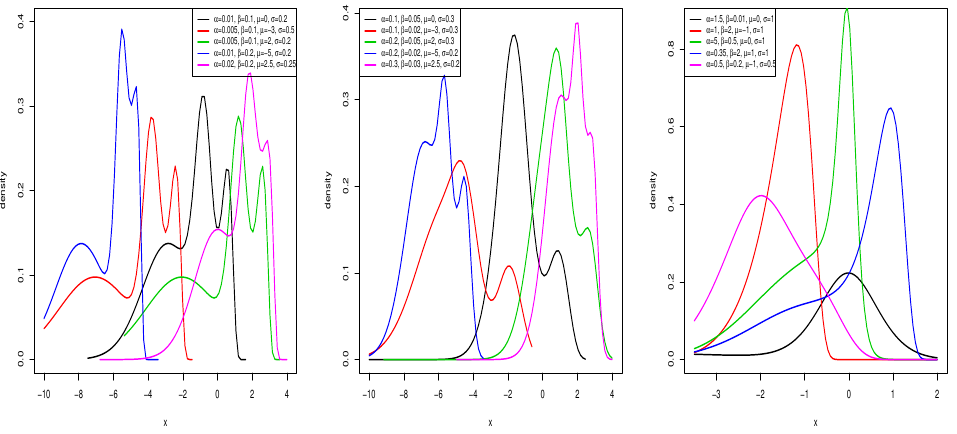
Figure 1. The pdf plots of the AOLLOW-N